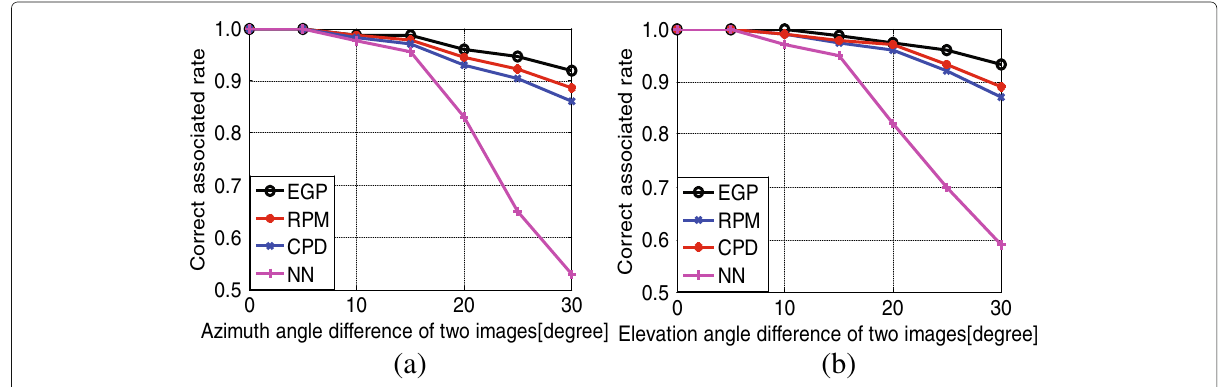
Fig. 4 Correct associated rate with rotation angles changing. a Keeping the same elevation angle and changing azimuth angle. b Keeping the same azimuth angle and changing elevation